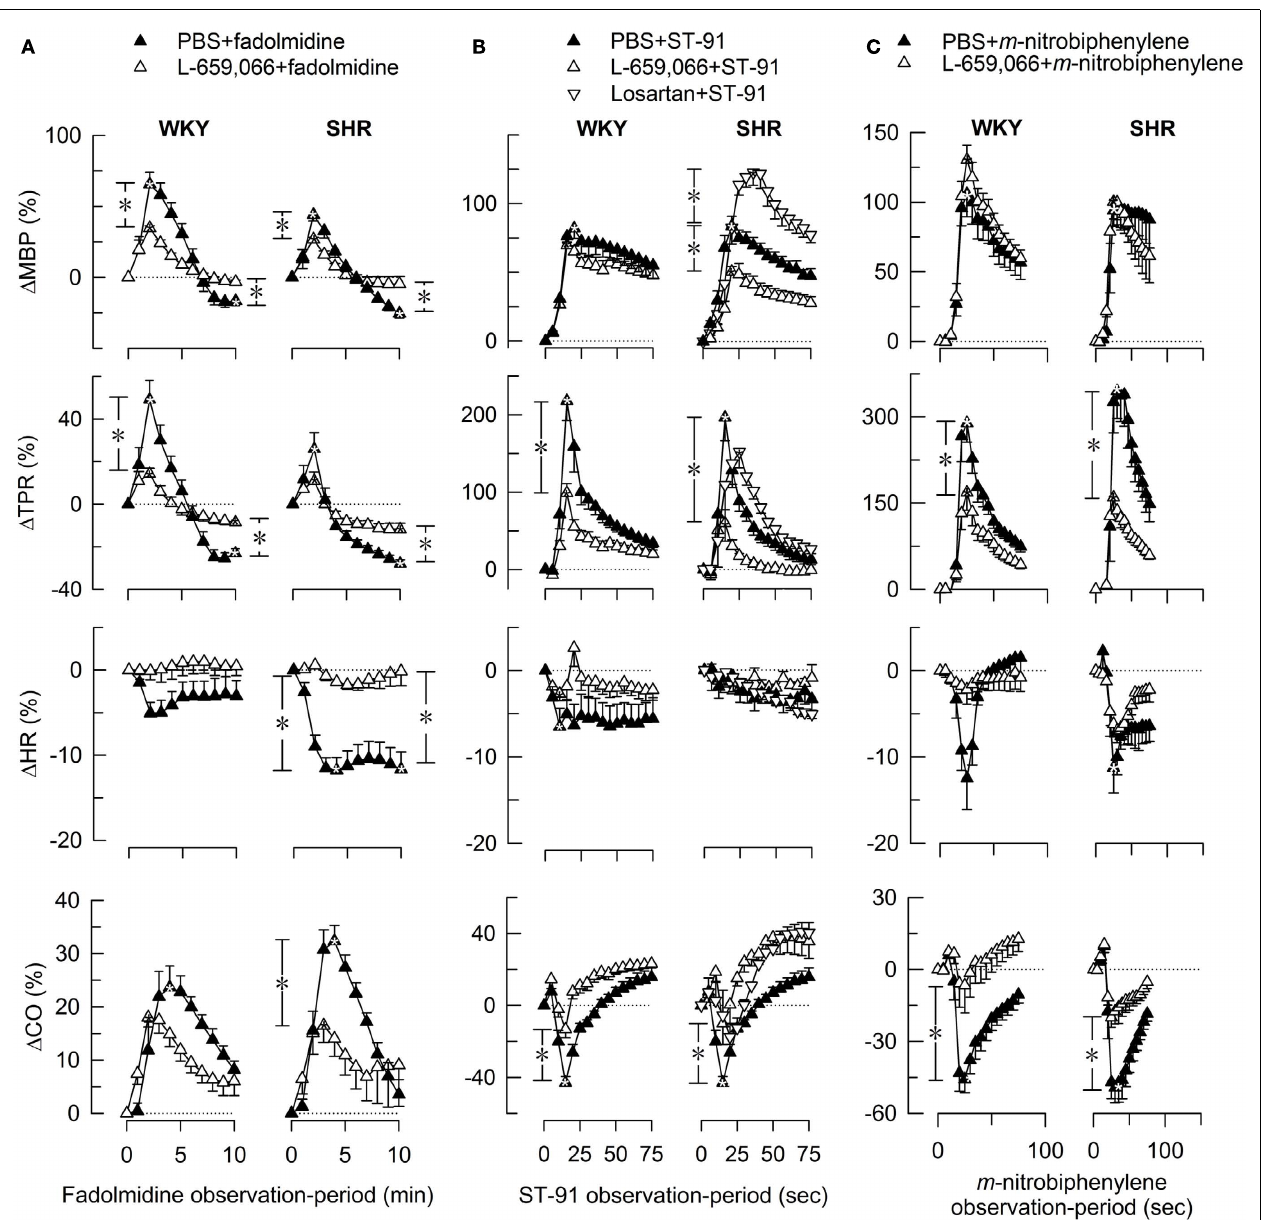
Variance and Covariance (please see Materials and Methods for details). Significant responses (*within symbols) and group differences ( * in brackets) were located as indicated at peak response (all agonists) (brackets left of curves) and after 15min (fadolmidine only) (brackets right of curves). *, * P ≤ 0.025 for (A) , and ≤ 0.05 for (B,C) after curve